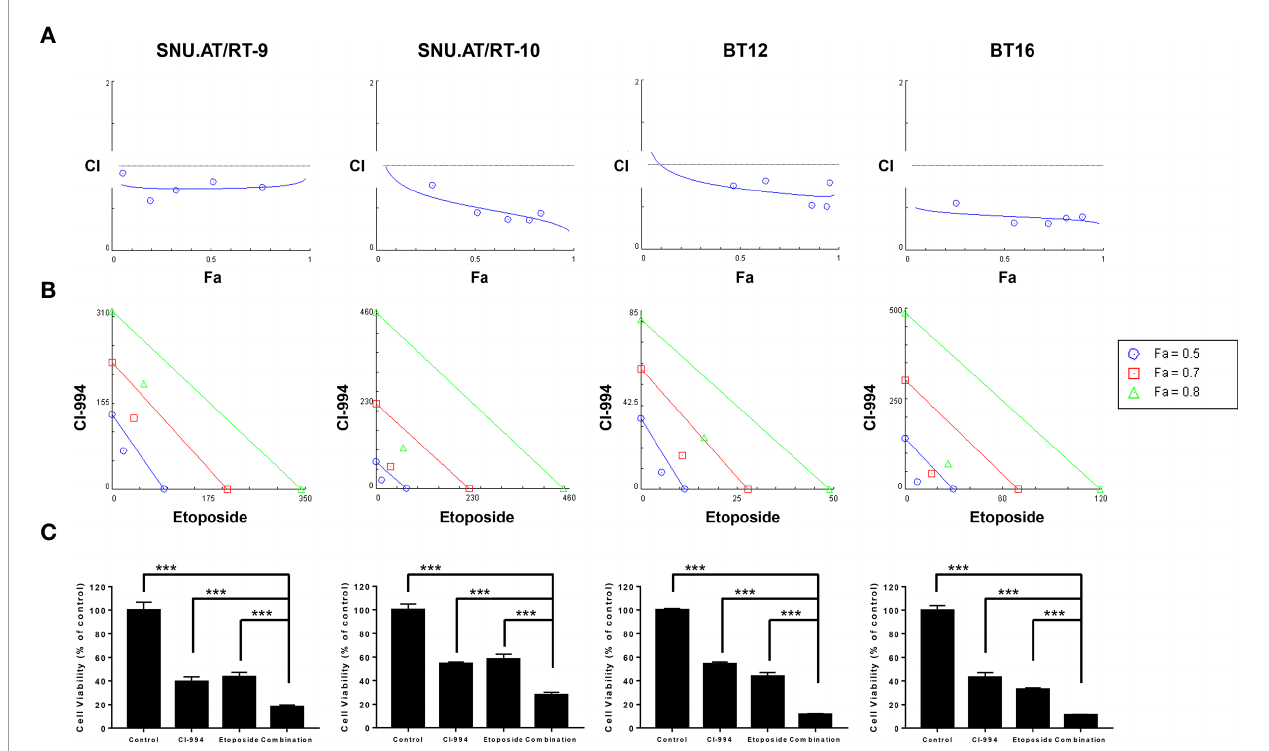
FIGURE 4 | Synergistic effect of the combination treatment of CI-994 with etoposide in atypical teratoid/rhabdoid tumor (AT/RT) cells. Fraction affected vs. combination index (Fa-CI) plot was calculated for the combination of CI-994 with etoposide using an isobologram. (A) Dose-response curve shows that if the combination points (blue lines) lie below the gray line, there is a synergistic effect. Low CI values with increased Fa values suggest better compatibility and high synergism between CI-994 and etoposide. Graphs show a synergistic effect in all AT/RT cells. (B) The blue, red and green lines represent the theoretical additive line and the 0.5, 0.7 and 0.8 values, respectively. The synergy between CI-994 and etoposide increases as the calculated values approach the origin. In all AT/RT cells, synergism was observed at concentrations with Fa 0.5, Fa 0.7 and Fa 0.8 points. (C) Combination treatment of CI-994 with etoposide was signi fi cantly more effective than single treatment in all AT/RT cells. ***p <